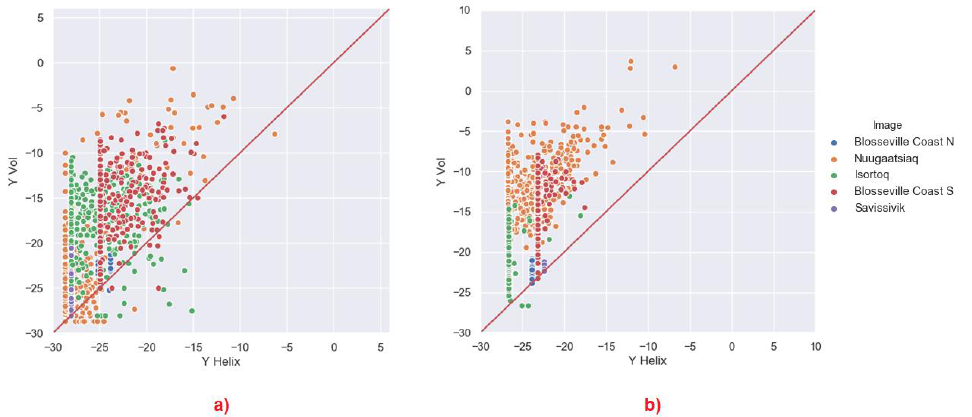
Figure 26. ( a ) Iceberg helix scattering, volume scattering plot in a 5 × 5 window, ( b ) 11 × 11 window. The majority of icebergs show more volume scattering. Colour legend indicates image. Dots indicate icebergs. All values are in dB.